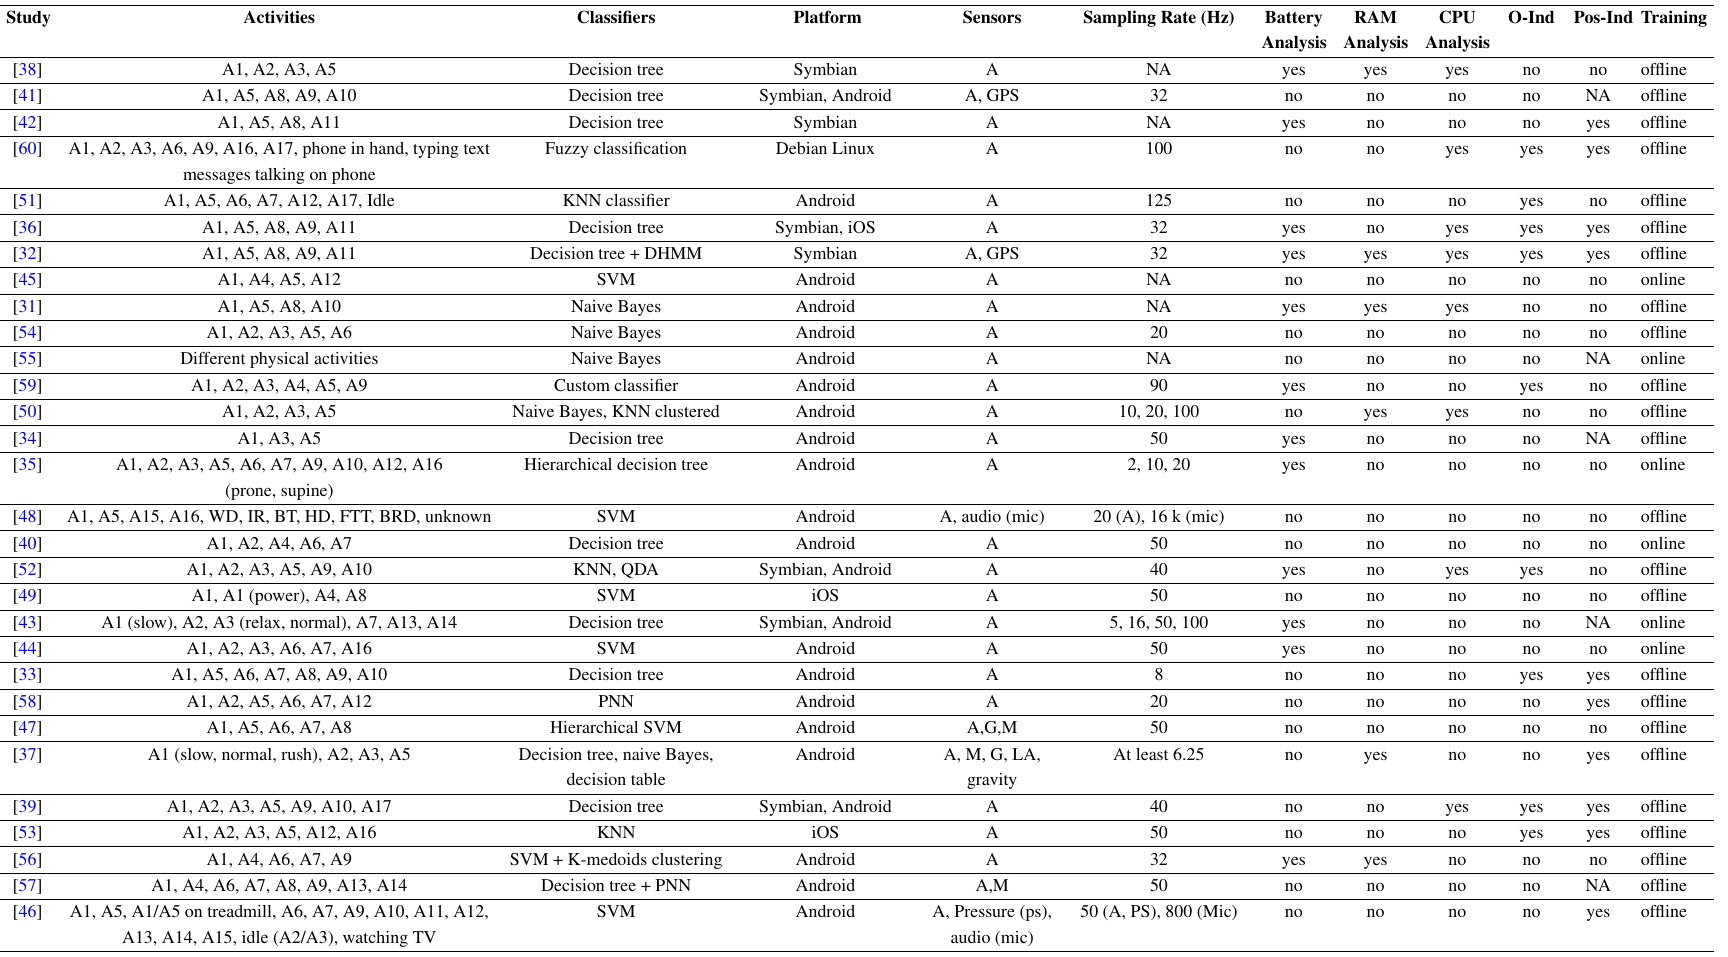
Table 14. Detailed comparison of all 30 studies. O-Ind: Orientation Independence; Pos-Ind: Position